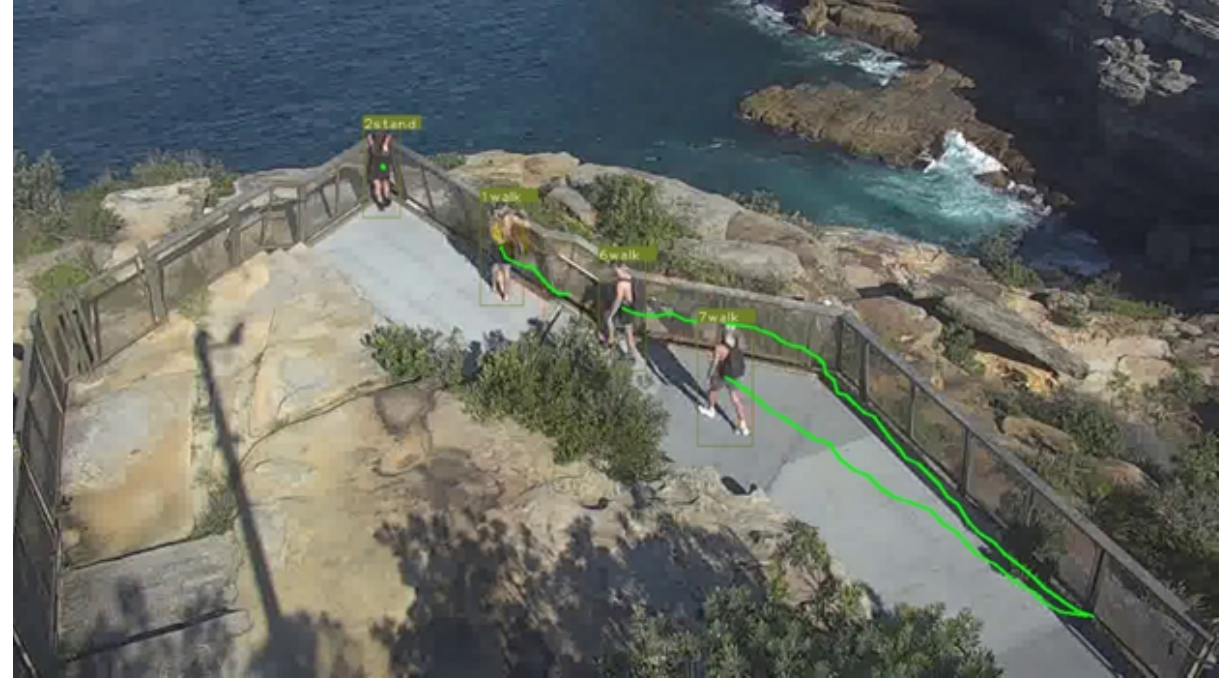
Figure 8. Example Output of the Analysis Pipeline. Individual pedestrians are shown with their unique IDs, recent trajectories, and action class (stand/walk). No groups were identified in this frame. Pose estimation has been omitted to improve visibility of the other outputs.